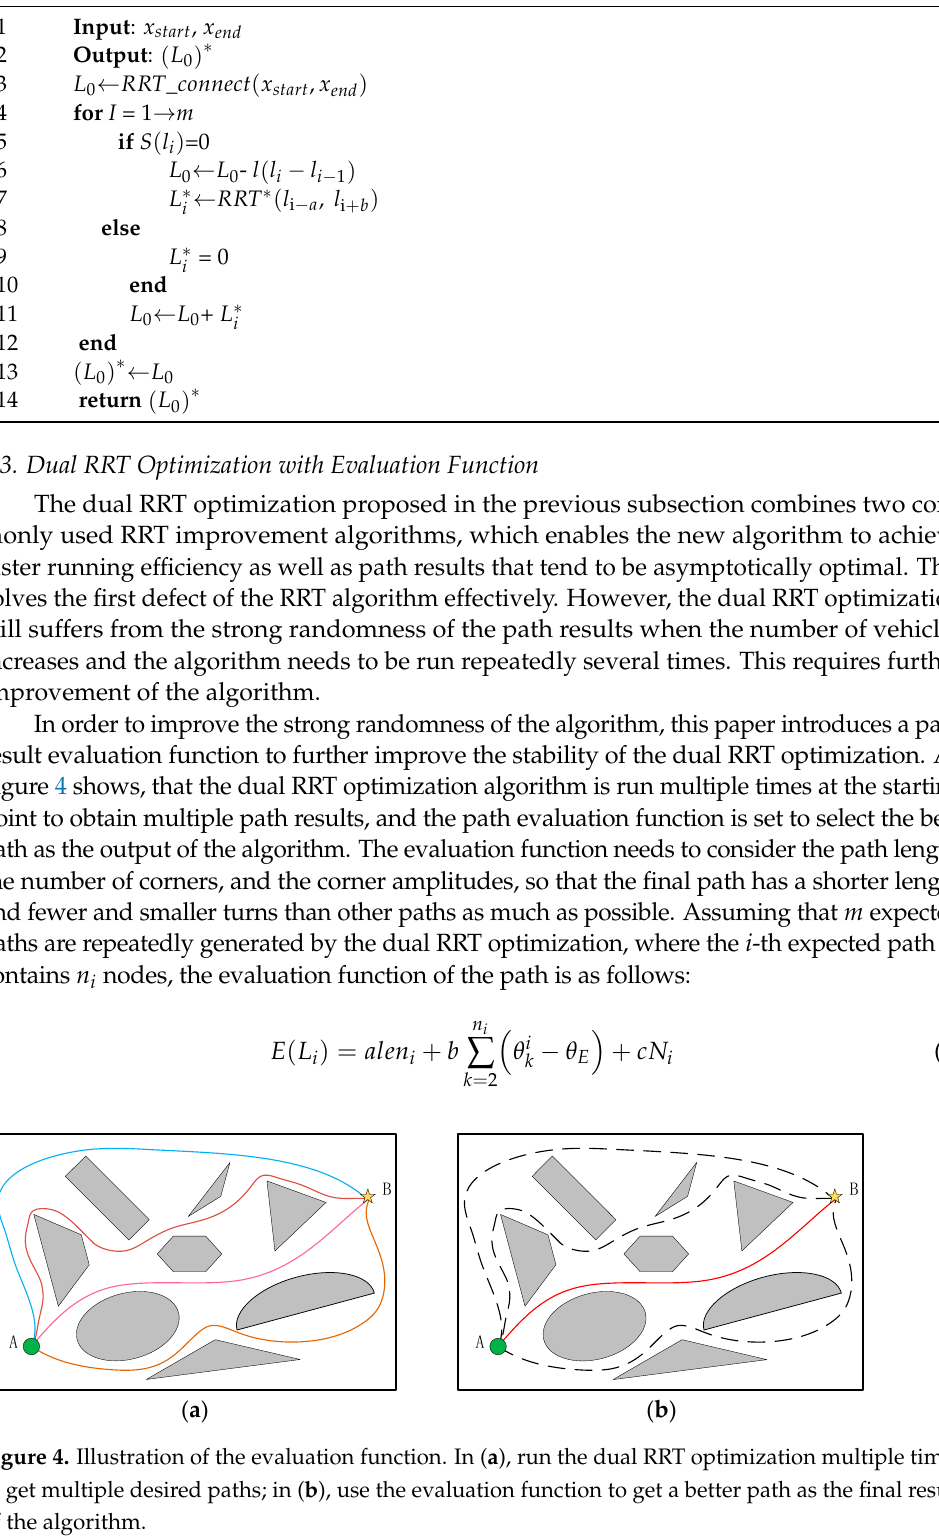
Algorithm 1: Dual RRT Optimization